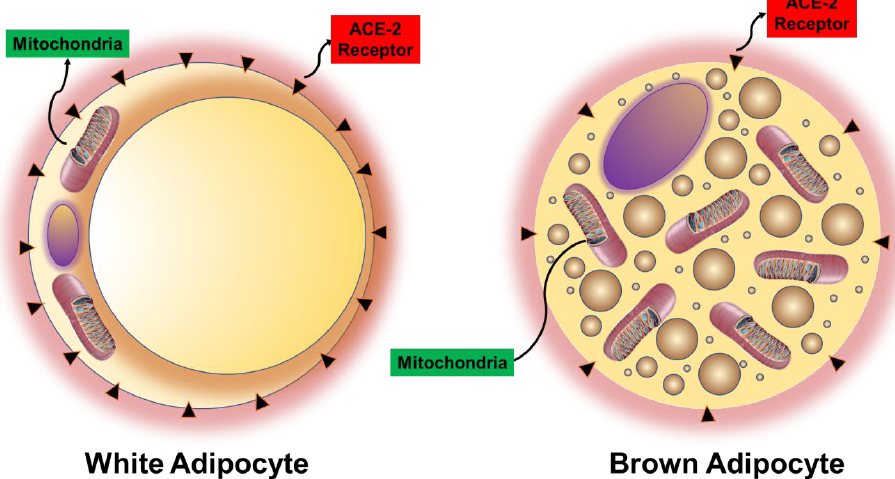
Figure 7. ACE-2 is overexpressed in adipose tissue in obesity and diabetes allowing COVID-19 to infect the cell. Lean (brown adipocyte) tissue is characterized by high amounts of mitochondria and HO-1 levels which result in low levels of ROS. Brown adipose tissue is better than white adipose tissue in its ability to handle the inflammation cause by COVID-19. Obese (white adipocyte) tissue is characterized by low amounts of mitochondria and HO-1, which results in high levels of ROS and upregulation of ACE-2 receptors, especially in morbid obesity and diabetes. COVID-19 patients with high amounts of white adipose tissue develop severe inflammation.